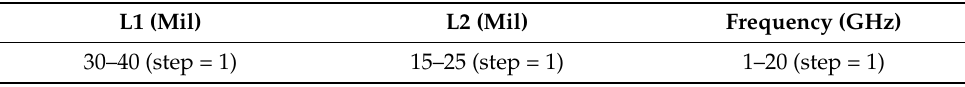
Table 4. Uniform sampling of rectangular inductor.